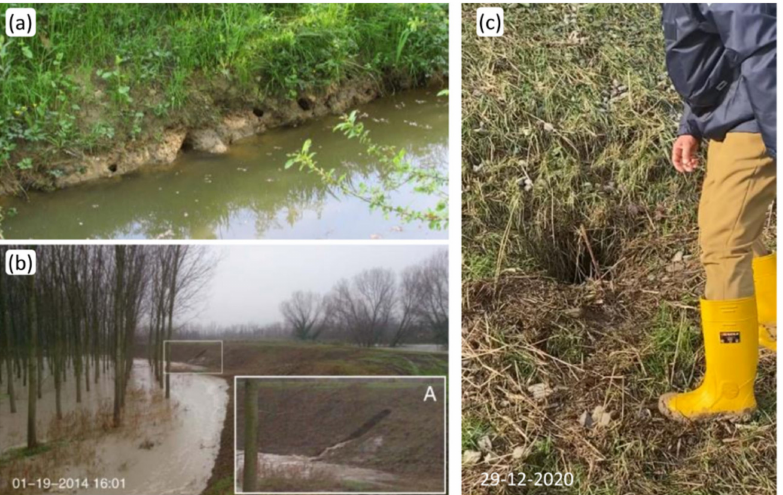
Figure 2. ( a ) Typical burrows produced by crayfish Procambarus clarkii on irrigation ditches (adapted from [4]); ( b ) concentrated erosion though a mammal burrow in Panaro levee near Modena (Italy) (adapted from [5]. WILEY 2005); ( c ) mammal burrow found on the land side of the Panaro levee near Modena